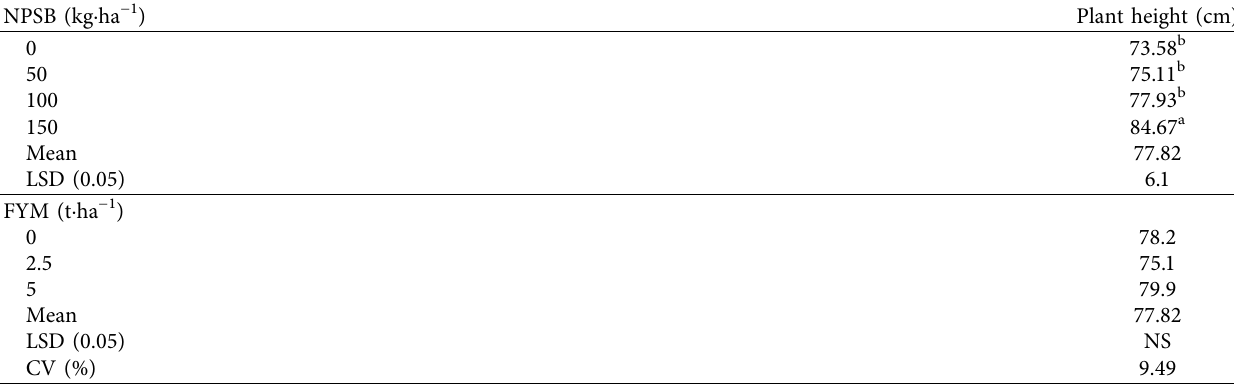
Table 4: Plant height as afected by NPSB fertilizer and FYM